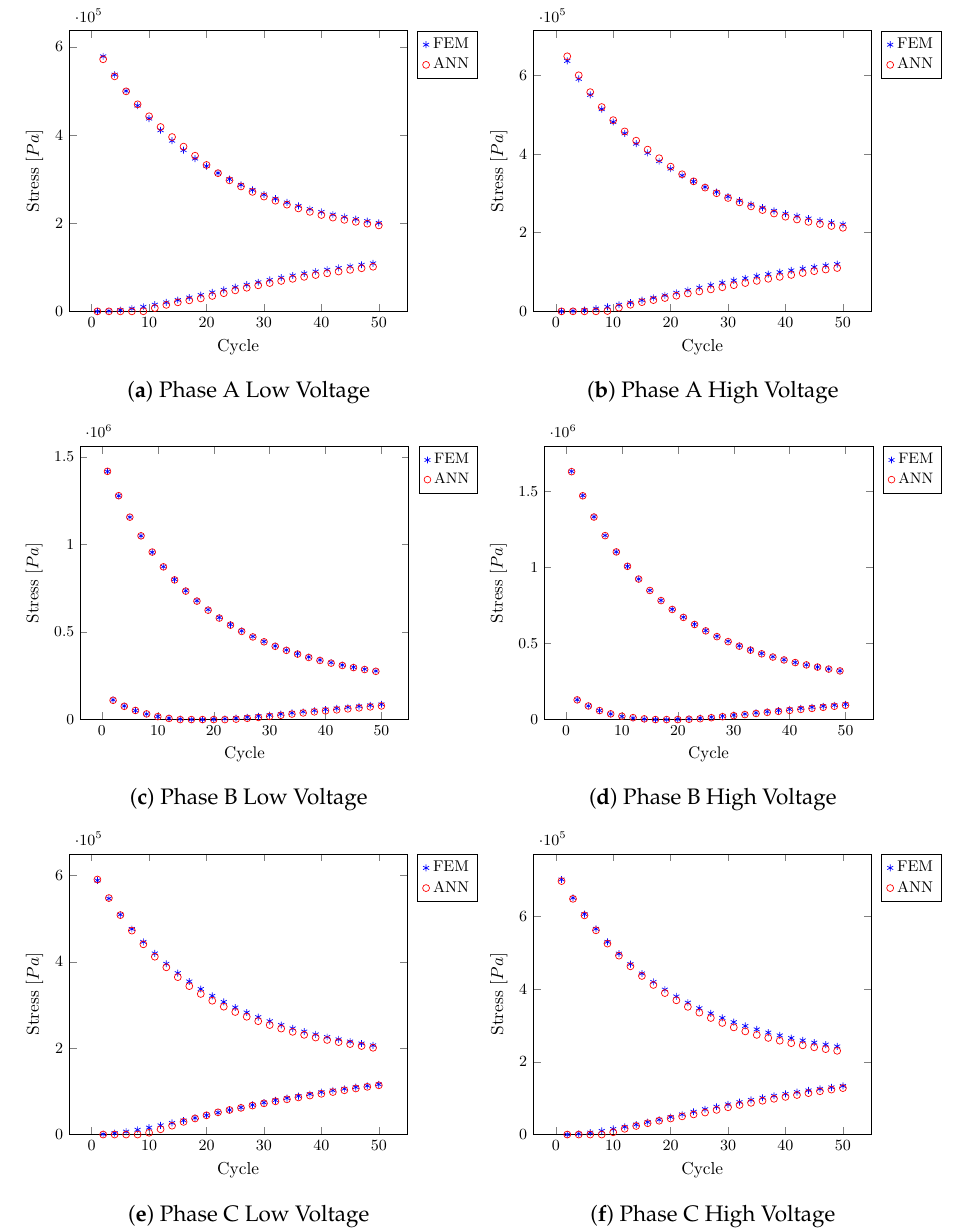
Figure 15. FEM and ANN simulations for a fault impedance of R = 1 Ω and X L = 80 Ω . The second event is a fault with a resistance R = 1 Ω and a reactance X L = 47 Ω (see Figure 16). The impedance is lower than in the first case, which causes higher stress on the conductors. The resistance/reactance ratio is also lower; hence, the transient ends faster and the difference between cycles of high stress and low stress is reduced at the end of the fifty cycles period. Some differences in the results of FEM and ANN are seen at the beginning of the phenomenon, mainly when the stress is high. Nonetheless, such difference is